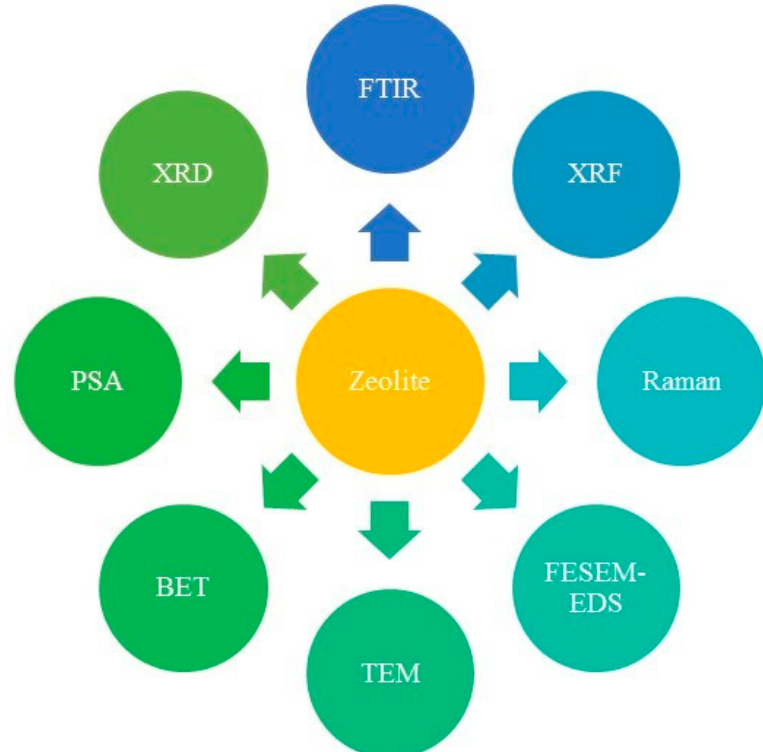
Figure 3. Different characterization techniques for zeolites.